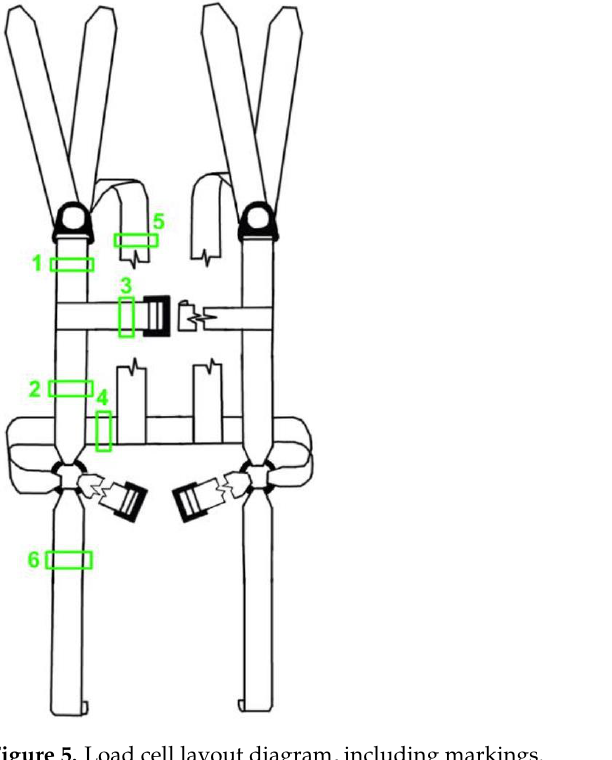
Figure 5. Load cell layout diagram, including markings.